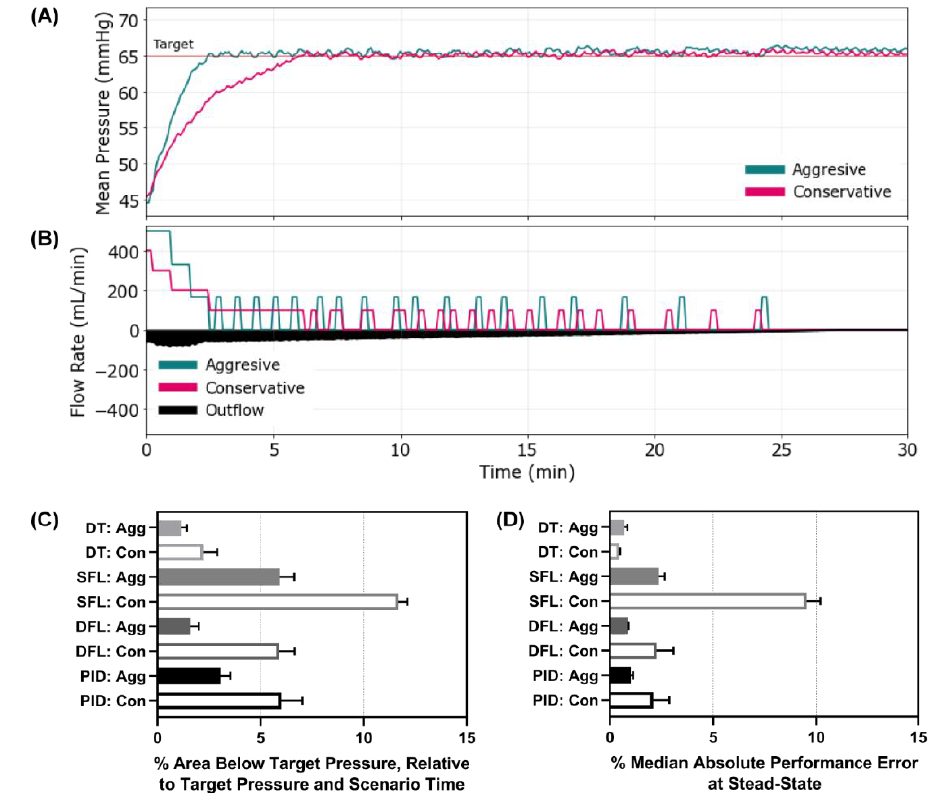
Figure 5. Controller performance for Scenario 3. Representative ( A ) MAP and ( B ) inflow/outflow vs. time for a single run of the aggressive and conservative decision table controllers through Scenario 3. Outflow rates are only shown for one controller run. In Scenario 3, MAP begins at 45 mmHg with an active hemorrhage clotting over the 30 min test run. Performance results for each controller type (DT = decision table; SFL = single-input fuzzy logic; DFL = dual-input fuzzy logic; PID = proportional– integral–derivative controller) and configuration (Agg = aggressive; Con = conservative) for the ( C ) area below target pressure (lower is better) and ( D ) median absolute performance error (MDAPE) at steady state (lower is better). Average results are shown for three subject variability runs for each. Error bars denote the standard deviation.